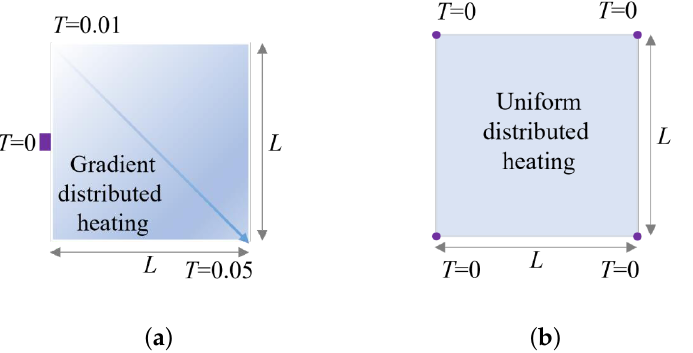
Figure 6. Numerical example model: ( a ) gradient distributed heating; ( b ) uniform distributed heating